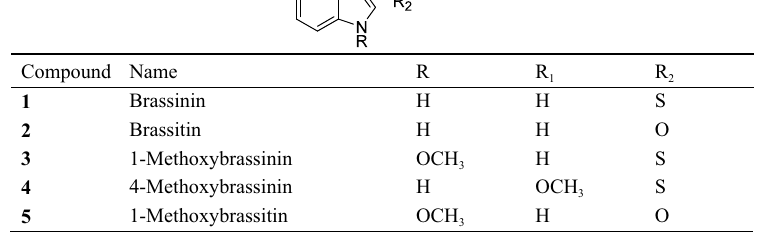
Fig. 2: Brassinin ( 1 ), brassitin ( 2 ), 1-methoxybrassinin ( 3 ), 4-methoxybrassinin ( 4 ) and 1-methoxybrassitin ( 5 )